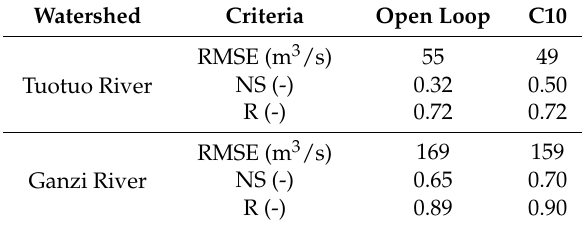
Table 2. Statistical criteria of daily streamflow simulation in two watersheds for two cases.